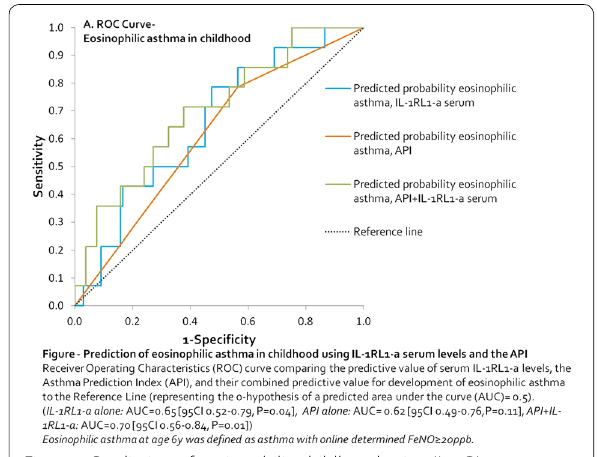
Figure 1 Prediction of eosinophilic childhood using IL-1 RL1-a serum levels and the